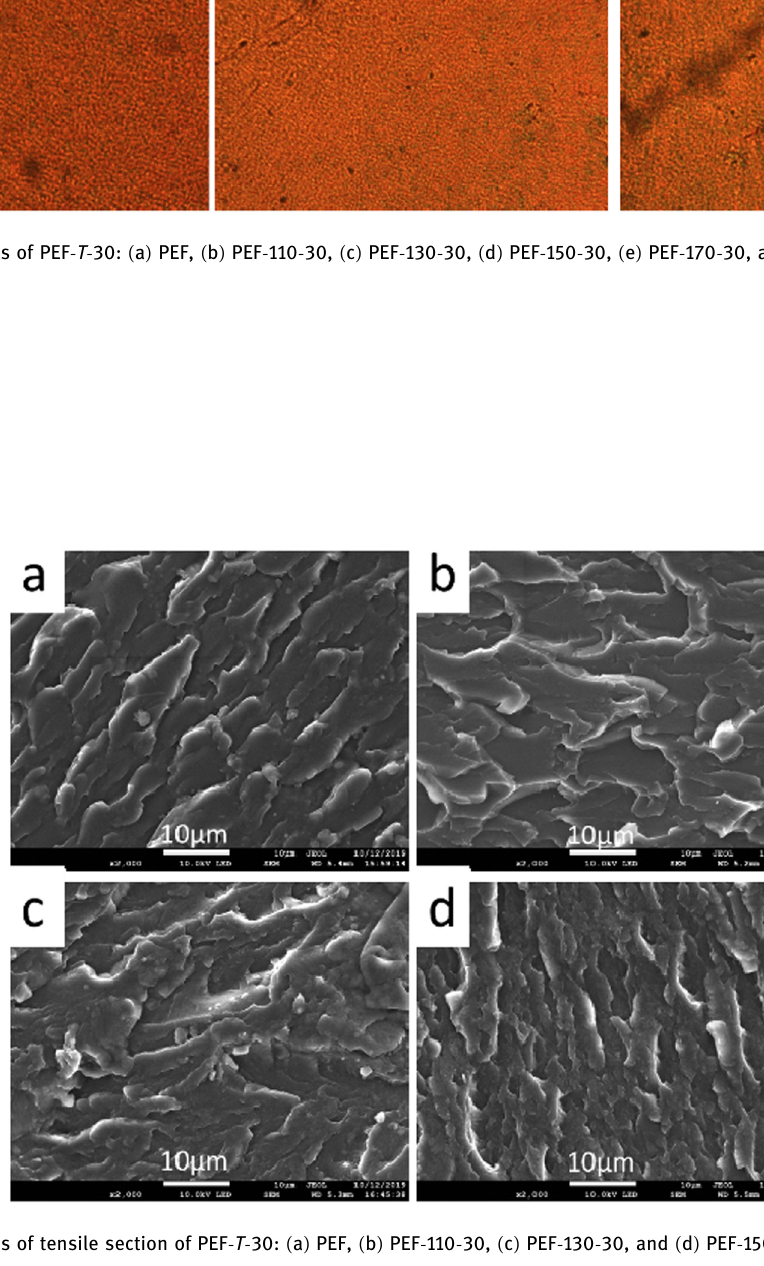
Figure A2: SEM photos of tensile section of PEF - T - 30: ( a ) PEF, ( b ) PEF - 110 - 30, ( c ) PEF - 130 - 30, and ( d ) PEF - 150 -